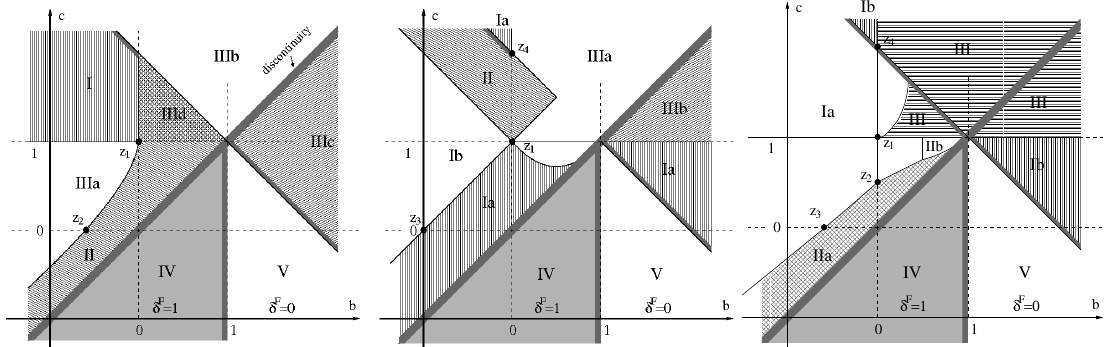
Figure 3. Illustration of the groups in pure, correlated and mixed strategies. The thick grey lines show the discontinuities between the